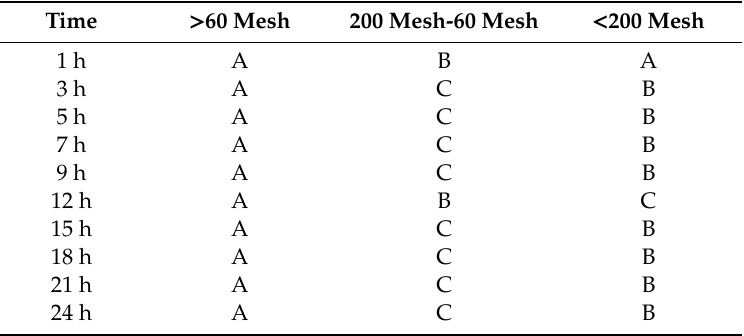
Table 3. Significance analysis of variance of activated carbon particle size.